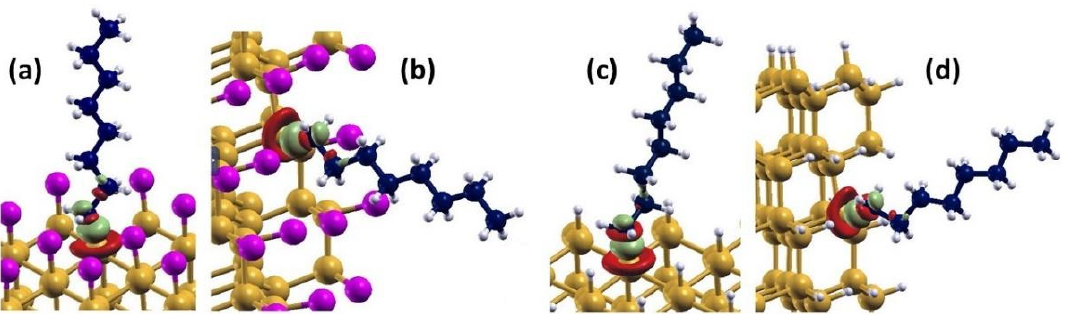
Figure 10. Isosurface of differential charge density of ( a ) Cl-SiNW-C 8 H 17 and ( b ) H-SiNW-C 8 H 17 with the adsorption of the octane moiety on ( a , c ) (111) surface, and ( b , d ) (110) surface. The isosurface value is set to 0.005 (mustard-color: Si atoms; white: H atoms; magenta: Cl atoms; blue: C atoms). Regions of green and red indicate charge accumulation and depletion, respectively.